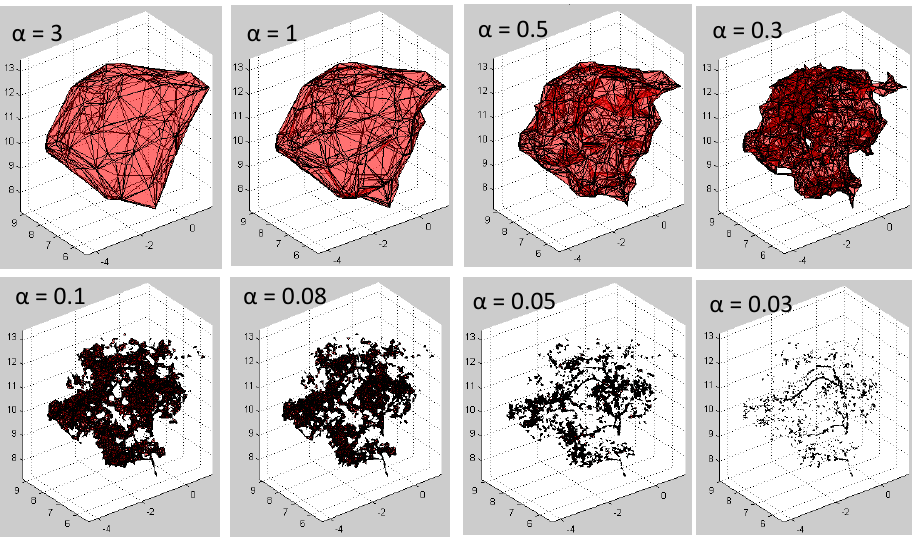
Figure 8. Delineation of branches and leaves from TLS ‐ generated cloud points: ( a ) classified branches in red and leaves in yellow; ( b ) volume of branches and ( c ) volume of leaves, estimated using alpha shapes.